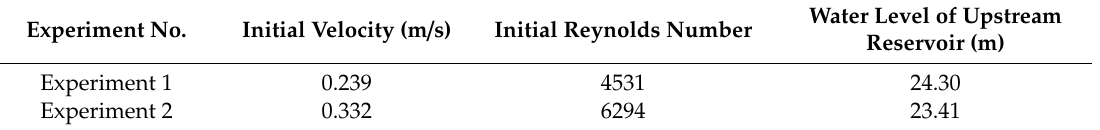
Table 1. Main parameters of di ff erent experimental schemes.